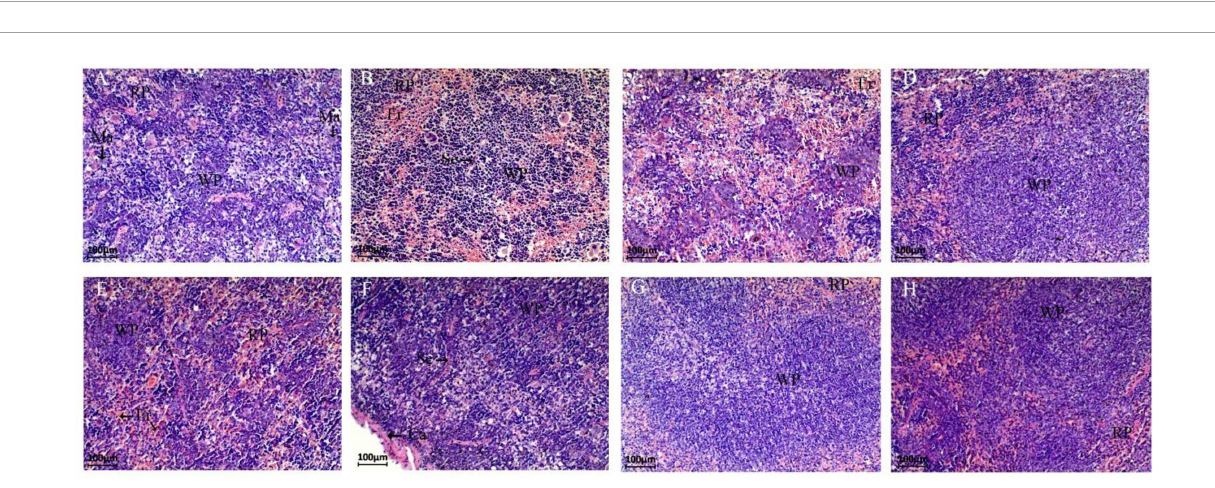
FIGURE4 Paraffin sections of mouse spleen tissue after different treatments. Morphological images of the spleen are shown at 40 × magnification. Panels (A–H) represent NC, CPM, CPC, EDC, EF, BS, LS, MC group. Ca: Capsule; RP: Red pulp; WP: White pulp; Ma: Macrophages; Se: Septum; Er: